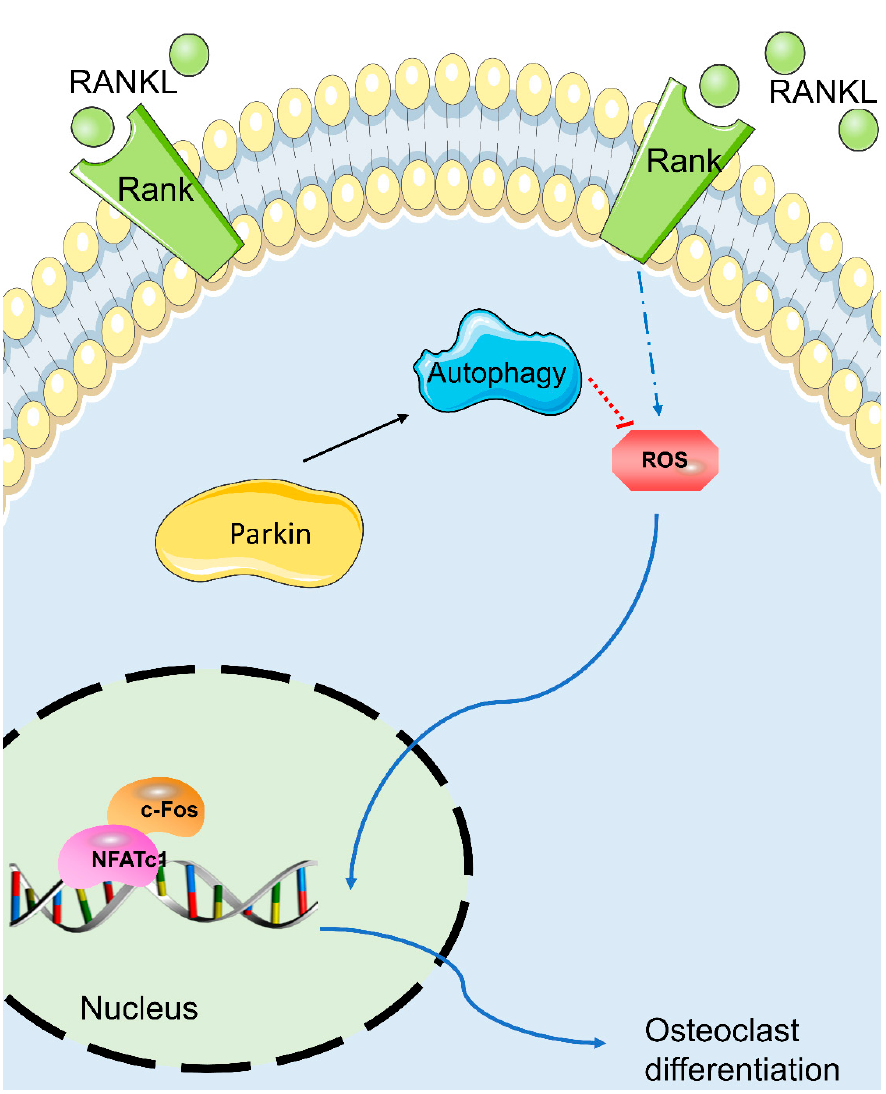
Figure 6. Schematic depicting the putative mechanism by which Parkin induces osteoclast differentiation. Osteoclasts are multinucleated macrophages derived from monocyte/macrophage precursors. RANKL binds with RANK on the surfaces of osteoclasts and precursors to activate downstream signaling pathways to promote osteoclast differentiation and function [35]. Osteoclasts express markers including TRAP, MMP-9, cathepsin K, NFATc1, ATPase, and c-Fos [36]. Following RANKL induction, c-Fos binds to the NFATc1 promoter to induce autoamplification during osteoclast differentiation [37]. NFATc1 is a master transcription factor that regulates the expression of osteoclast-specific genes such as MMP-9, TRAP, cathepsin K, and ATPase [38]. In this study, Parkin significantly decreased the expression levels of TRAP, MMP-9, cathepsin K, NFATc1, ATPase, and c-Fos. Furthermore, Parkin significantly reduced the number of TRAP-positive cells, decreased the size of F-actin rings, and reduced the number of bone resorption